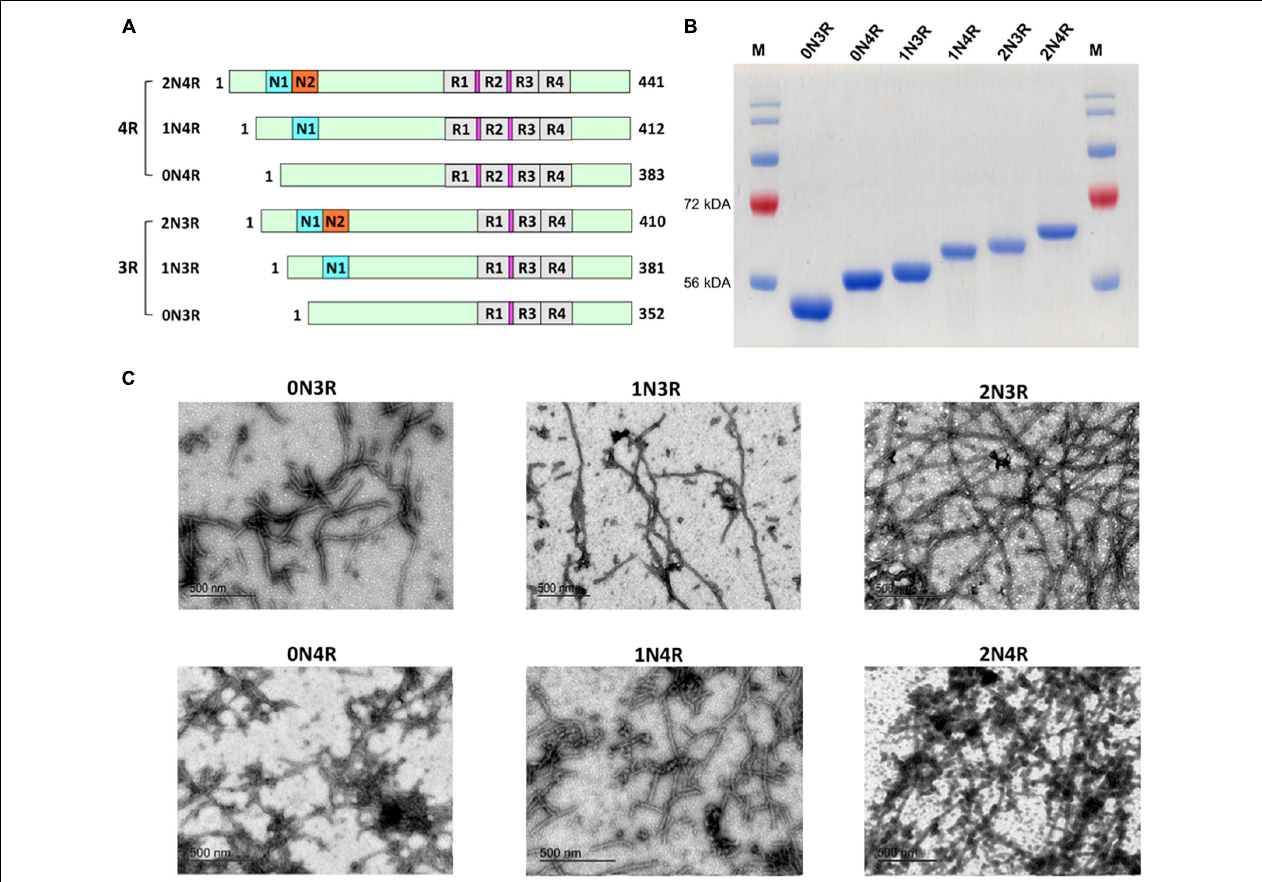
FIGURE 1 | Human tau isoforms. (A) Schematic illustration of the alternative spliced six isoforms of human CNS tau. Amino-terminal insert domains (N1 and N2) and carboxy-terminal repeat domains (R1-R4) are shown. Amino acid residue numbers for each isoform are listed. Locations for the hexapeptide sequences (VQIINK in R2 and VQIVYK in R3) are highlighted in magenta. (B) SDS-PAGE analysis demonstrated six recombinant human tau isoforms purified to homogeneity. (C) TEM images of mature filaments of all six human tau isoform are shown. 30 µ M of each tau isoform was prepared in 20 mM Tris pH 7.4 with 0.06 mg/ml heparin and incubated at 37 ◦ C for 12 days. Mature tau isoform fibrils were visualized after staining with uranyl